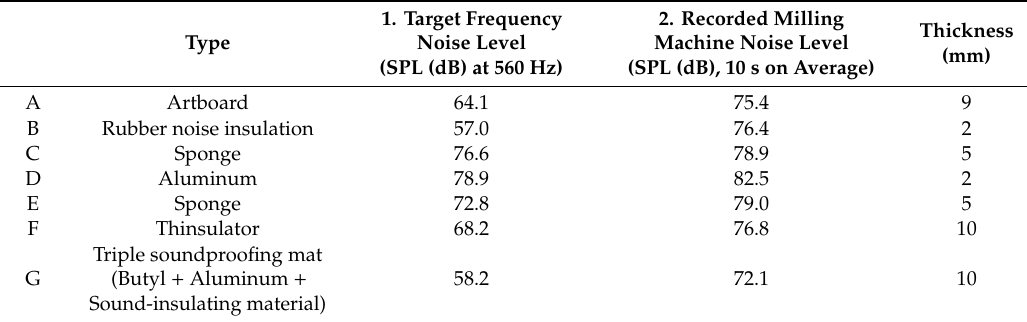
Figure 7. Target noise source setting and prevention technology selection. ( A ) operational range of active and passive noise reduction (active NR and passive NR); ( B ) frequency weighting curves. A-weighting is commonly used for a rough estimate of the frequency sensitivity of human hearing. Table 1. Performance evaluation results of various